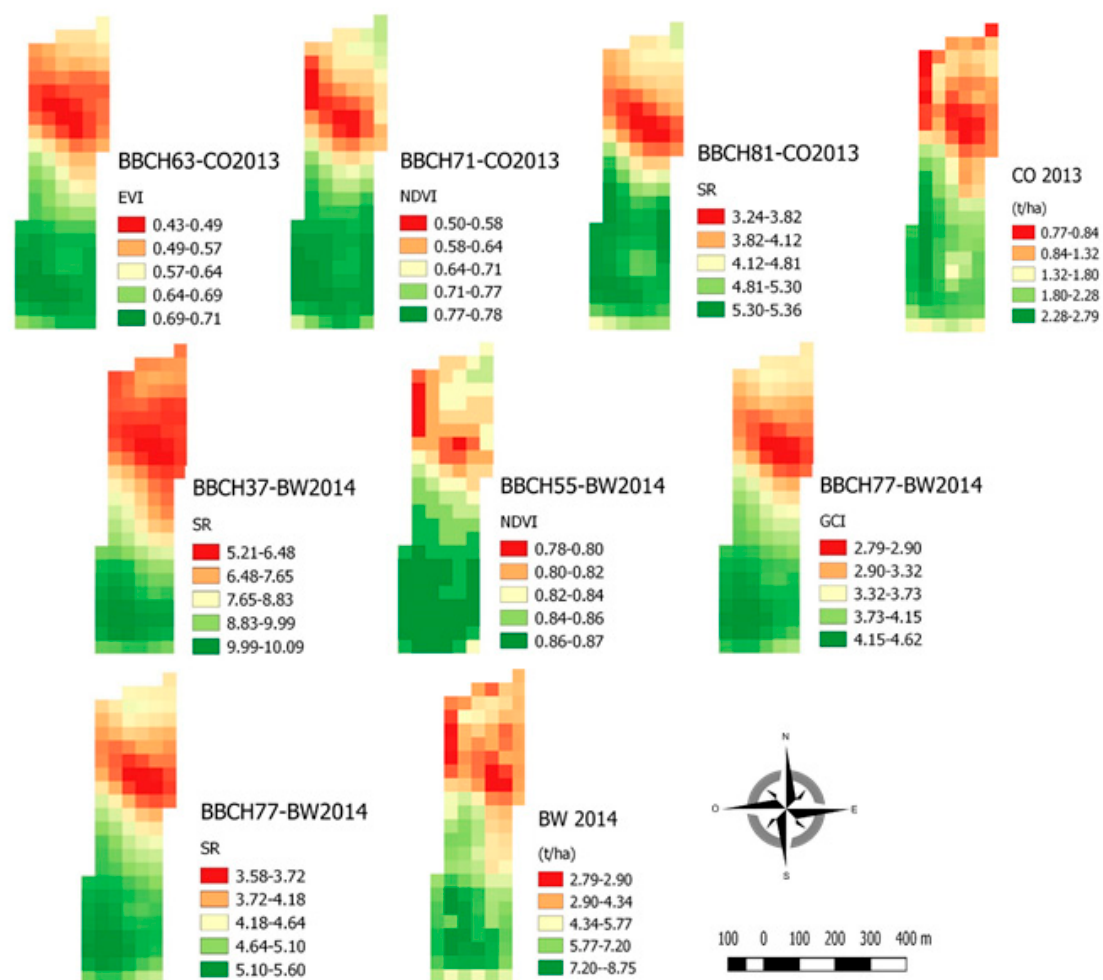
Figure 3. Spatial variability maps of remote VIs and crop yields with 30 m cell size.